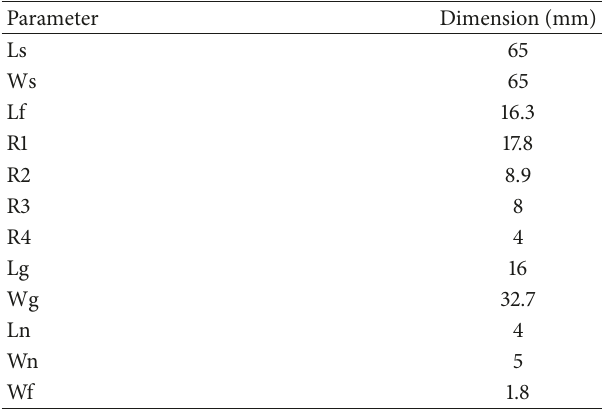
Table 1: Dimensions of the Antenna